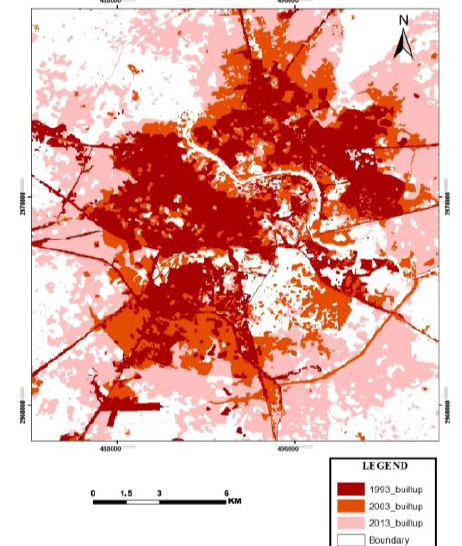
Figure 8: Built up